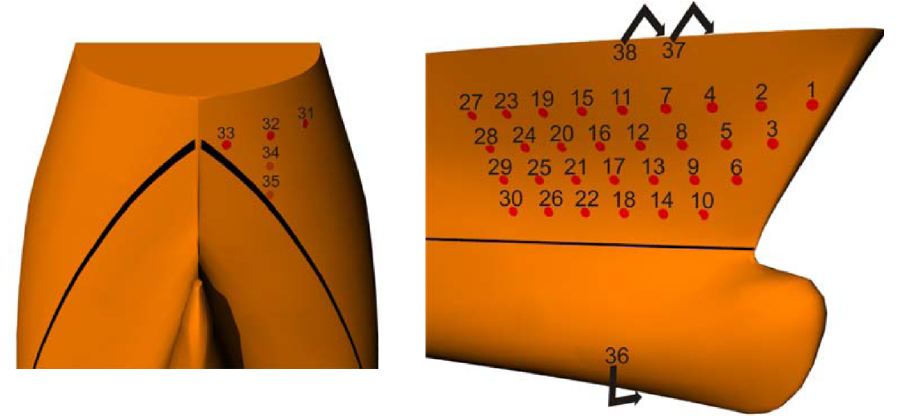
Figure 19. LNG carrier: pressure sensor locations at the ship’s stern and bow